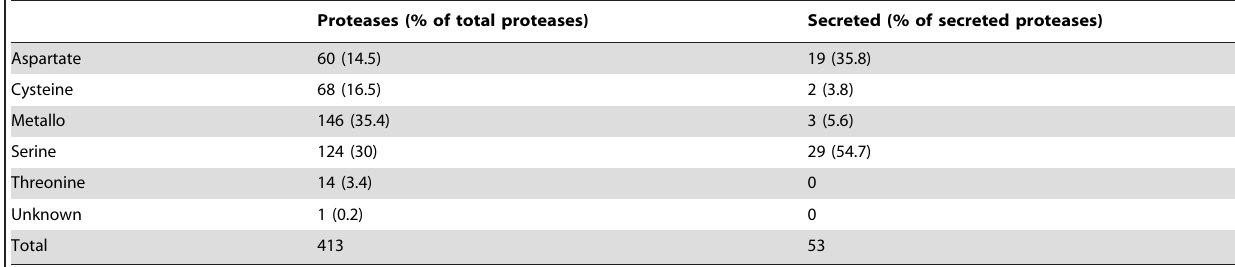
Table 3. Protease families in the L. corymbifera